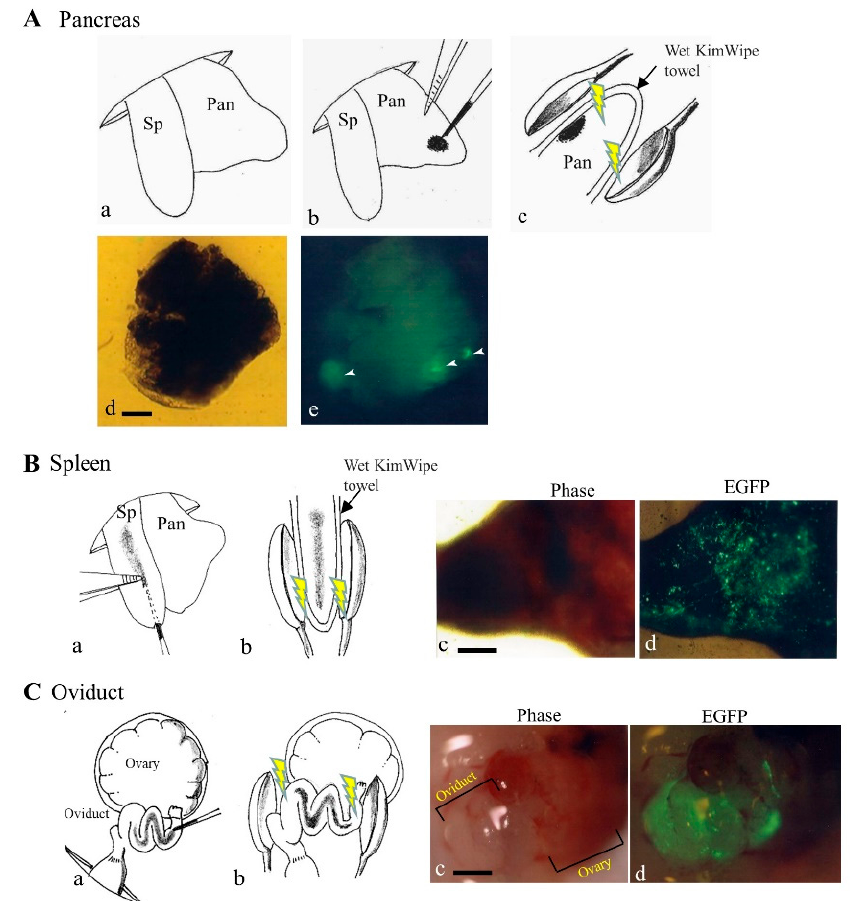
Figure 4. In vivo gene delivery to pancreas ( A ), spleen ( B ), and oviduct ( C ). ( A ) The gene delivery method to pancreatic parenchyma is illustrated by schematic representation (a–c) and photographs (d,e), all of which are derived from our paper [56] under permission of MDPI. Spleen (Sp) and pancreas (Pan) were exposed after dorsal incision of skin and muscle wall under anesthesia